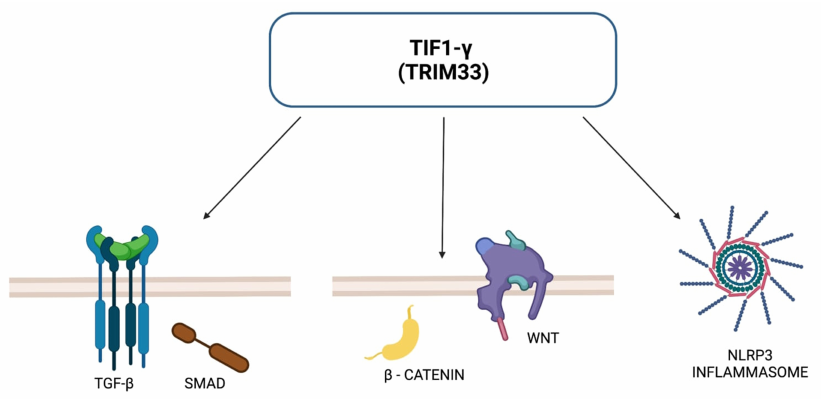
Figure 2. TRIM33-dependent pathways for tumor suppression.